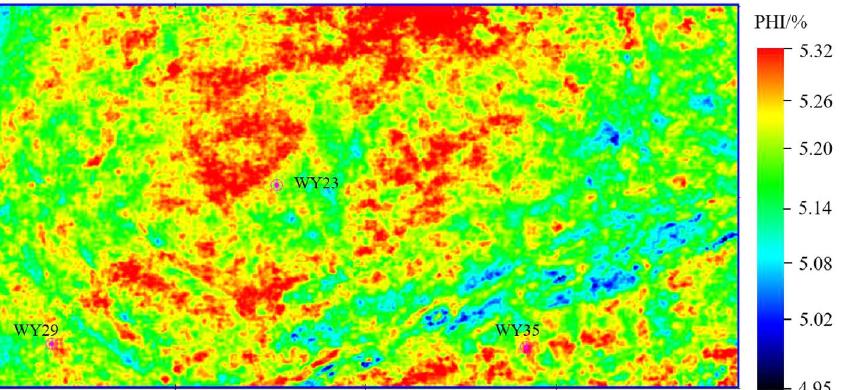
Figure 14. PHI distribution of the target reservoir layer.